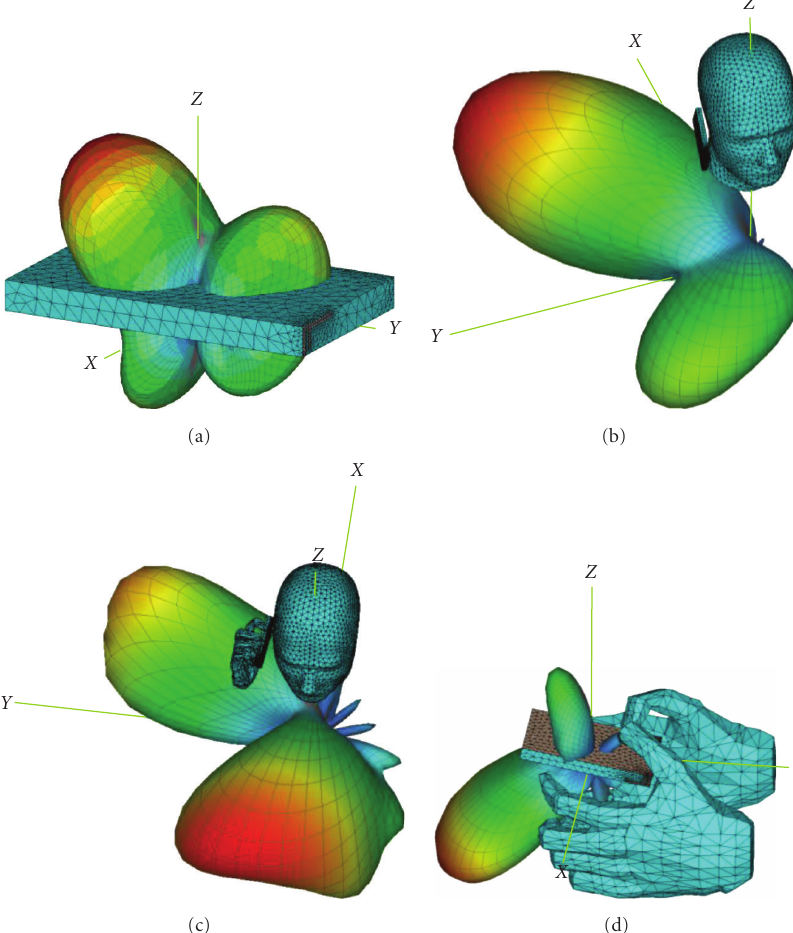
Figure 6: Total 3D radiation patterns of the MIMO design: (a) without the user, (b) voice position with the user head, (c) voice position with the user head and hand, and (d) data position with the user